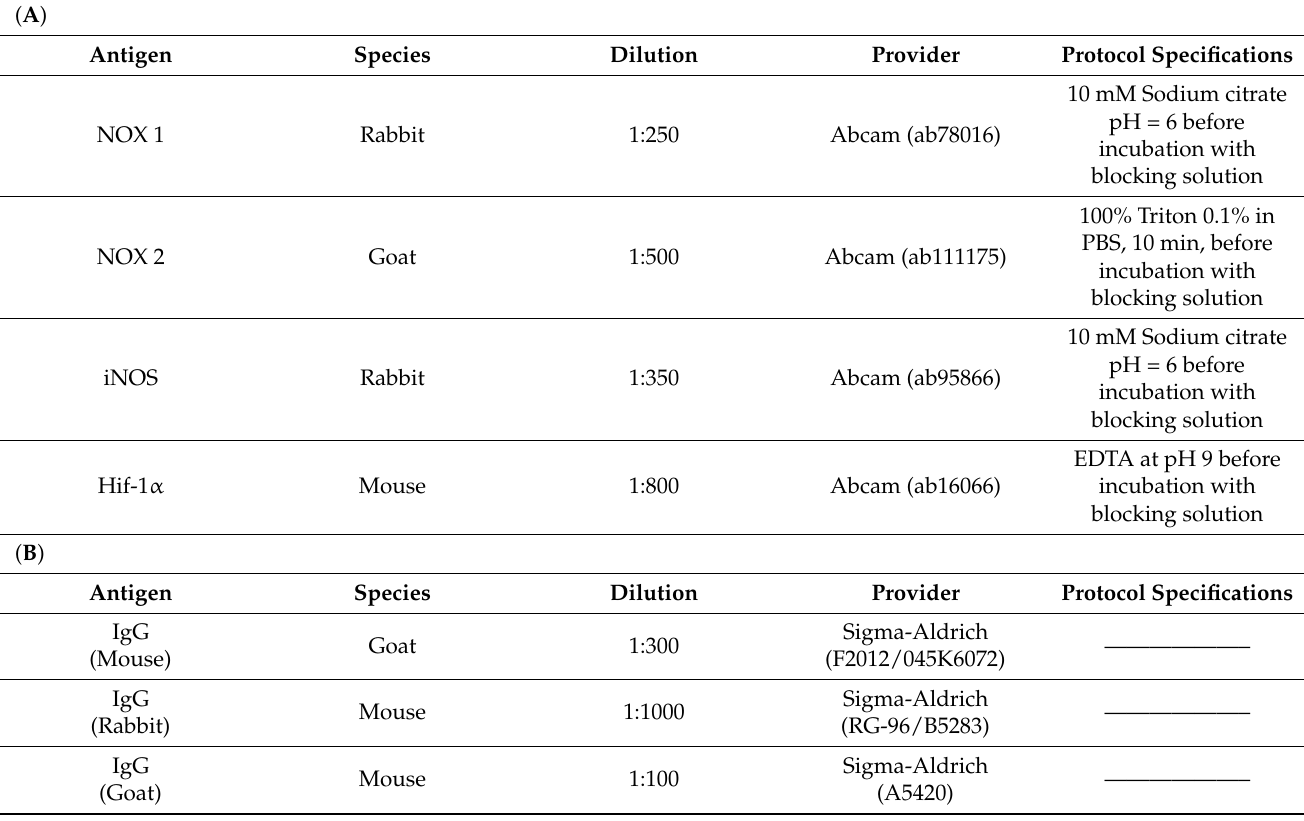
Table 3. Primary ( A ) and secondary ( B ) antibodies used in the immunohistochemical studies performed, showing the dilutions used and the protocol